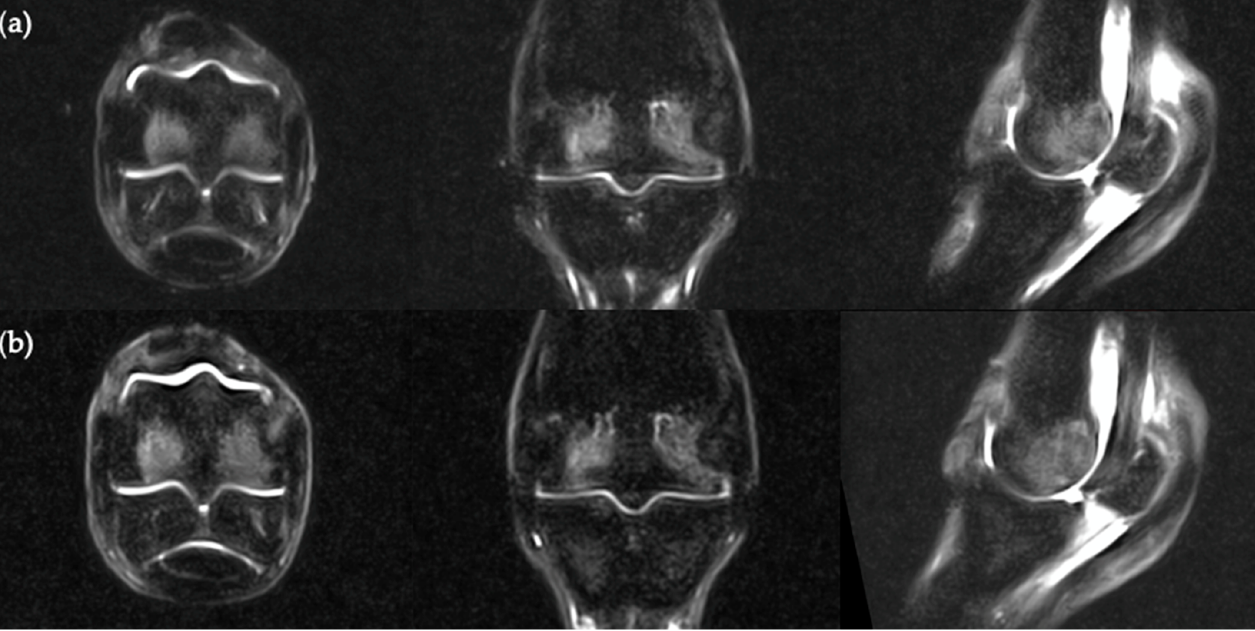
Figure 5. STIR FSE MR images in transverse, frontal and sagittal planes of the same cadaver limb ( a ) after and ( b ) before a freeze-thaw process.